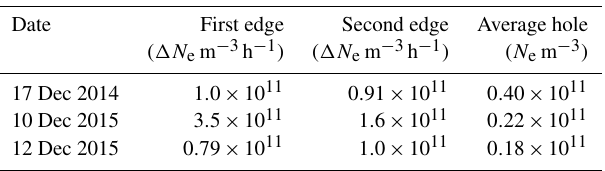
Table 1. The electron density gradient at each edge of the polar hole, and the average electron density inside the hole at 350km observed by the ESR